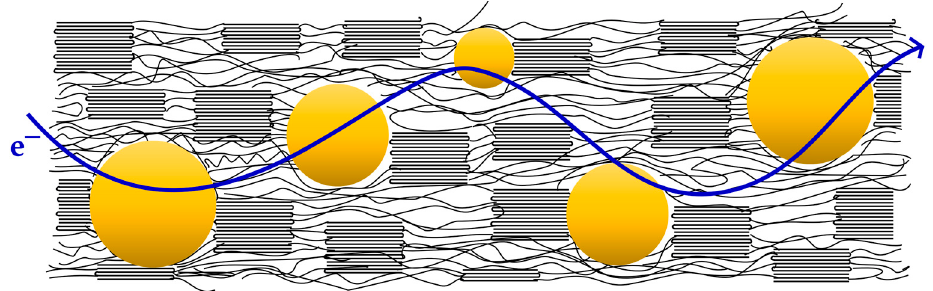
Figure 12. Conductivity scheme of nanocomposite polyacrylonitrile fi bers.